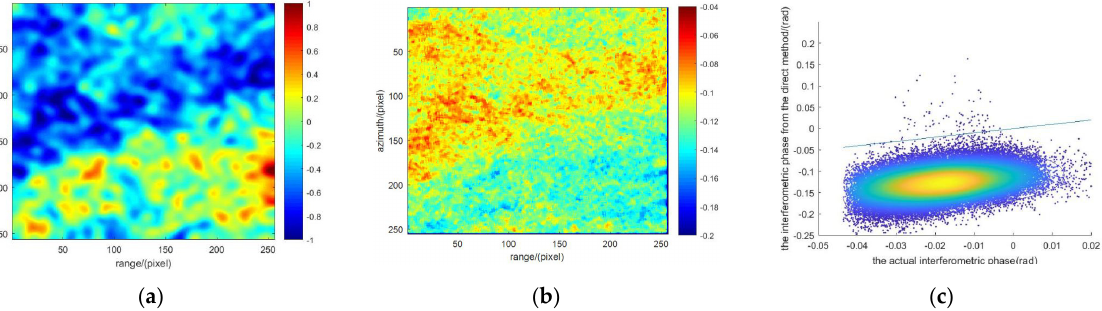
Figure 21. Results of the direct method: ( a ) the calculated current filed, ( b ) the simulated interferometric phase, and ( c ) the scatter density map of simulated and extracted interferometric phases.